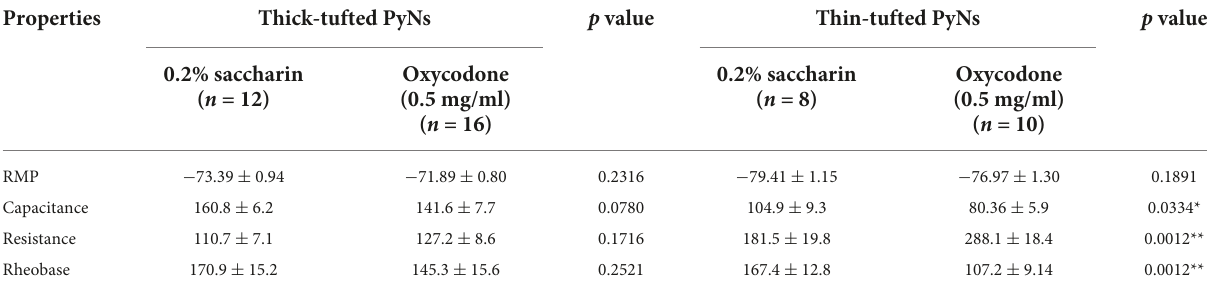
TABLE 1 Electrophysiological properties of thick- and thin-tufted